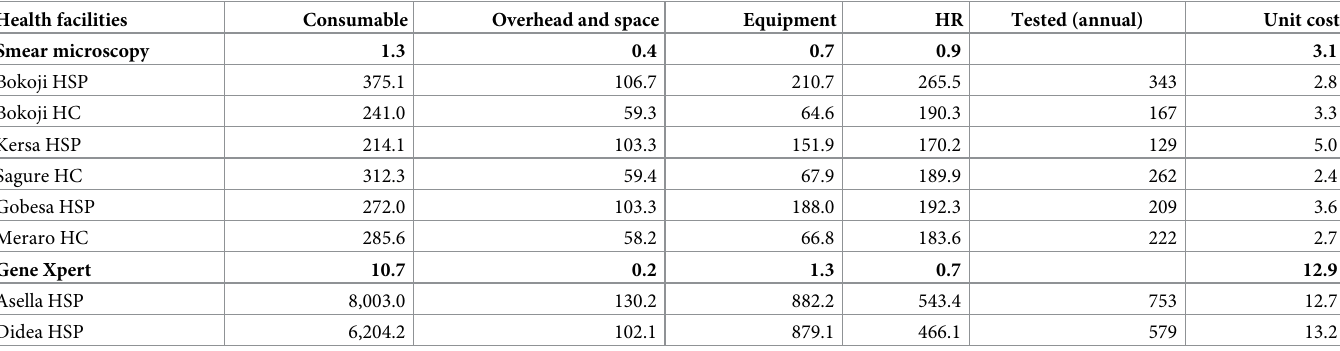
Table 2. Unit cost per patient tested of smear microscopy and the Gene Xpert diagnostic method (2018 US$). Health